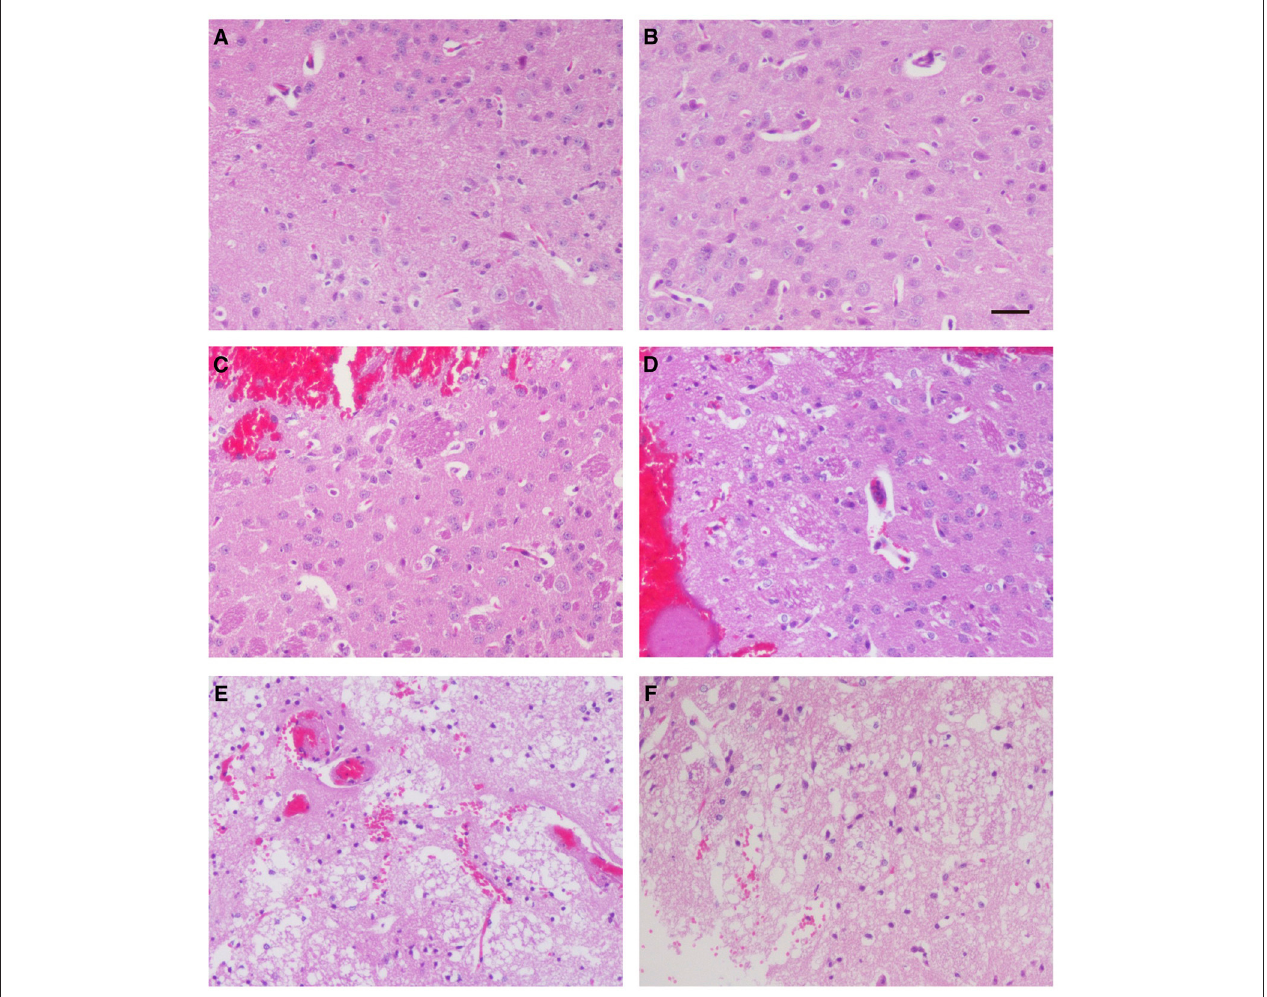
FIGURE 6 | Histopathological examination of mouse brain tissues 6 h after injection. Hematoxylin-and-eosin staining of the caudate putamen in brain tissues from blank control mice (A,B) , control mice injected non-specific peptide (C,D) , and mice injected with the mimic ZCP peptide (E,F) . Bars: 100 µ